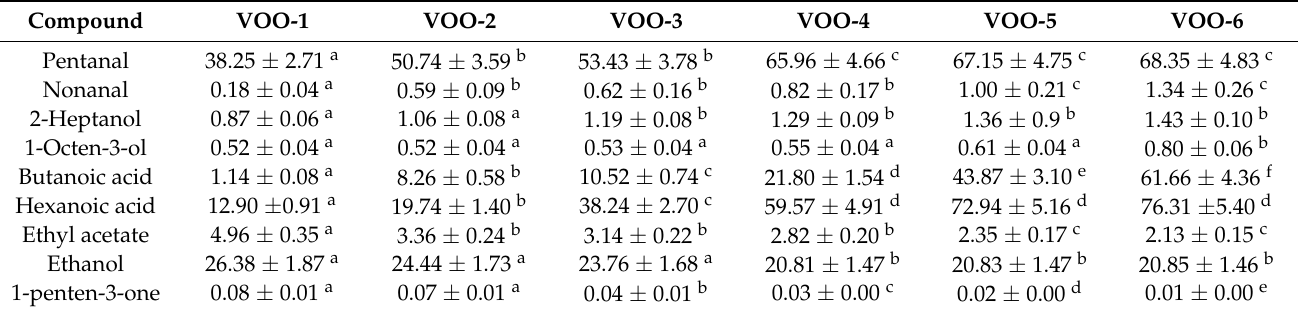
Table 2. Concentration (mg/Kg; mean ± SD) of volatile compounds of the VOO samples during the six months of storage.